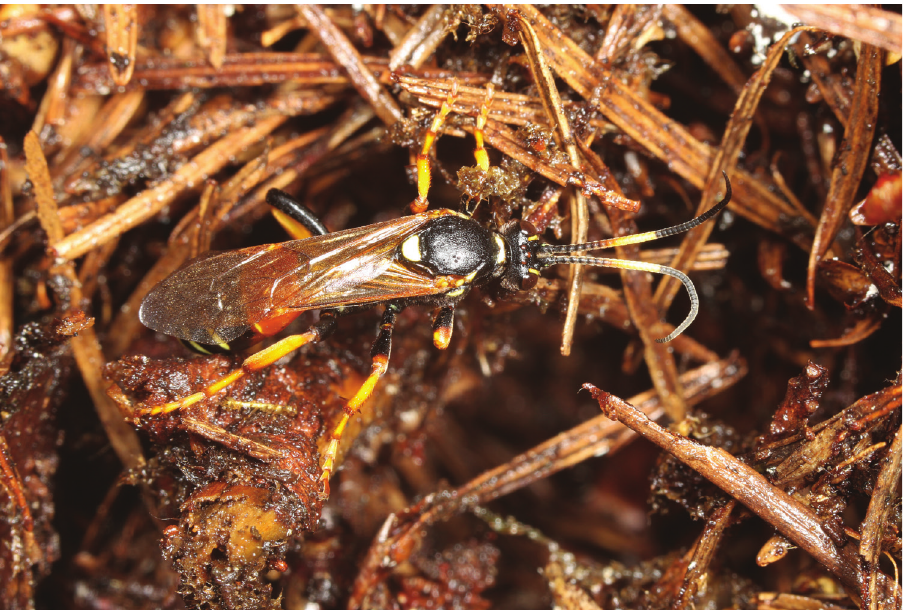
Figure 2. A female of Diphyus amatorius (Müller, 1776), found hibernating beneath decaying leaves, while searching for heteropterans; the Netherlands, Ommen (Varsenerveld), 13 November 2019. Gerard